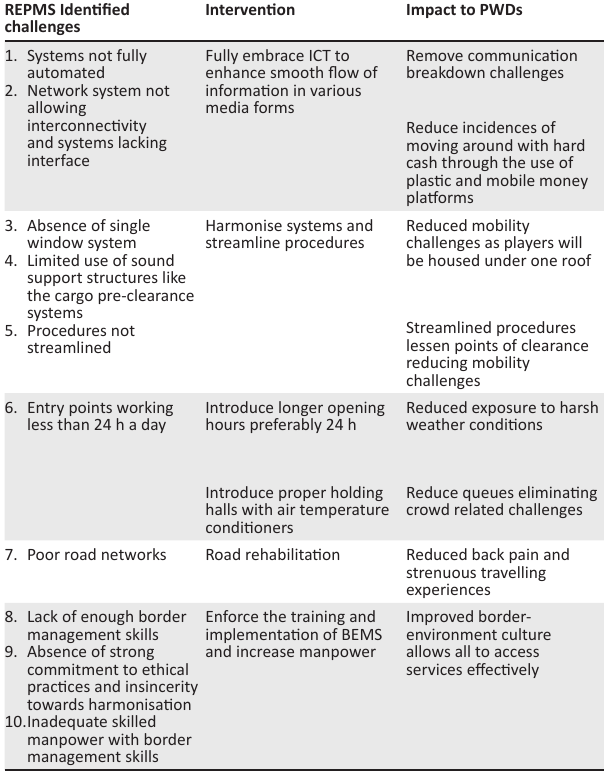
FIGURE 1: Stakeholders’ triad in the removal of road entry point management systems hidden TABLE 3: Interventions to alleviate hidden disablers.